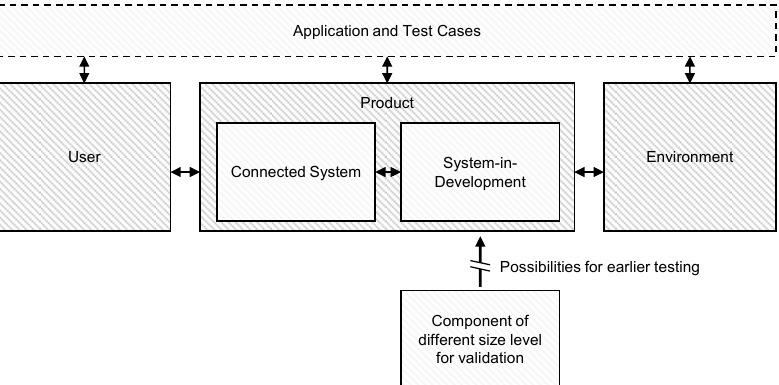
Figure 1. Early validation with XiL-approach by including available components of different size levels in a test bench.